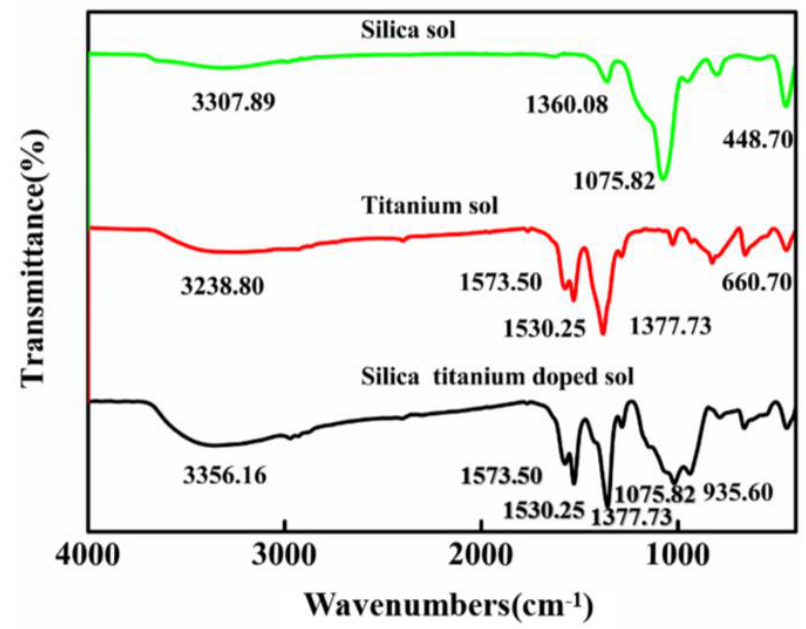
Figure 2. Infrared spectrum of gel solution. Figure 2 shows the infrared spectra of pure silica sol, pure titanium sol and SiO 2 -TiO 2 composite sol. In the spectrum of pure silica sol, the peak at 3307.89 cm − 1 is belong to the stretching vibration of residual -OH that come from the incomplete hydrolysis condensation of siloxane. In the figure, at 1075.82 cm − 1 [27] was the Si-O stretching vibration peak in the silica sol, and at 448.70 cm − 1 was the Si-O-Si stretching vibration absorption peak. In the infrared spectrum of titanium sol, 3238.80, 1530.25 and 660.70 cm − 1 [28] was the residual -OH stretching vibration peak, the Ti-O bond stretching vibration absorption peak and the Ti-O-Ti stretching vibration absorption peak, respectively. In the IR spectrum of composite sol, a new peak appears at 935.60 cm − 1 , which was the stretching vibration absorption peak of Si-O-Ti. The organic-inorganic hard coating solution of SiO 2 -TiO 2 sol was prepared by sol-gel method. The complete hydrolysis of tetrabutyl silicate needs more than 24 h, while the hydrolysis of titanium isopropoxide is completed within 1 h. Due to the great difference between the two hydrolysis rates, the complexing agent acetylacetone was introduced in the reaction process to control the hydrolysis rate of titanium isopropoxide and equimolar water was added for pre-hydrolysis of tetrabutyl silicate. Thus, the hydrolysis rates of the two precursor were matched. A large number of Si-O-Ti bonds were formed in the coatings, which made a crossed structure between nano-TiO 2 and nano-SiO 2 particles in the coatings, and greatly improved the hardness of the coating.